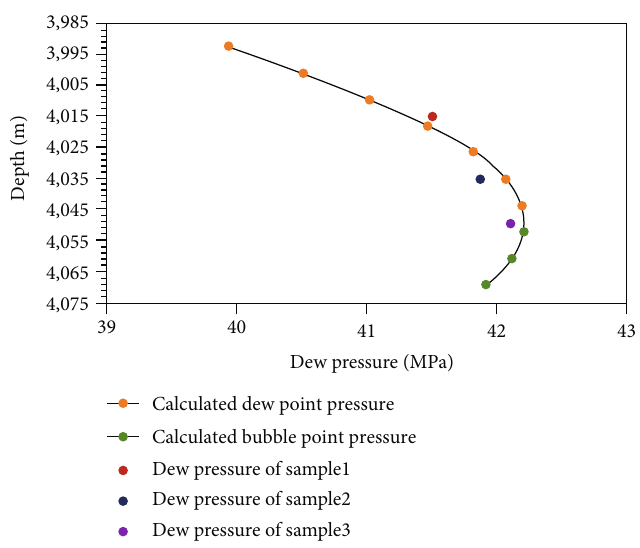
Figure 8: Dew point pressure of the original fl uid in S condensate reservoir.